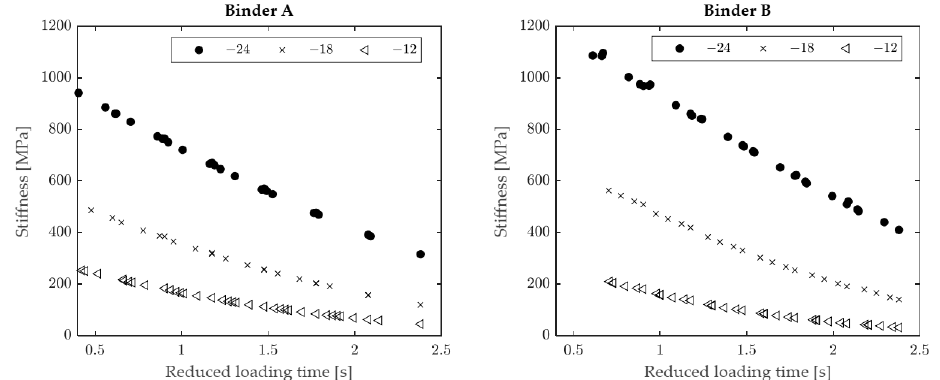
Figure 5. Experimental stiffness at conditioning aging time of 1 h, for different temperatures, as a function of loading time.